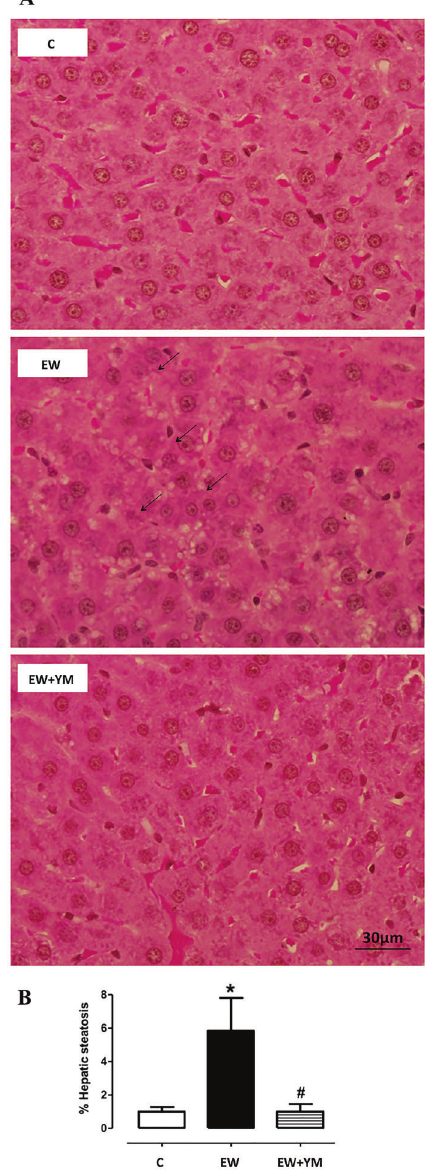
Figure 6. Yerba mate treatment prevented the increase of liver triglycerides induced by early weaning. Liver triglycerides content at postnatal day 180 of adult rats that were normally breastfed for 21 days (C), early weaned (EW), or EW that received yerba mate for 30 days (EW + YM). Data are reported as means ± SE of 10 rats per group. *P o 0.05 vs C; # P o 0.05 vs EW (ANOVA and Newman-Keuls multiple comparison test).